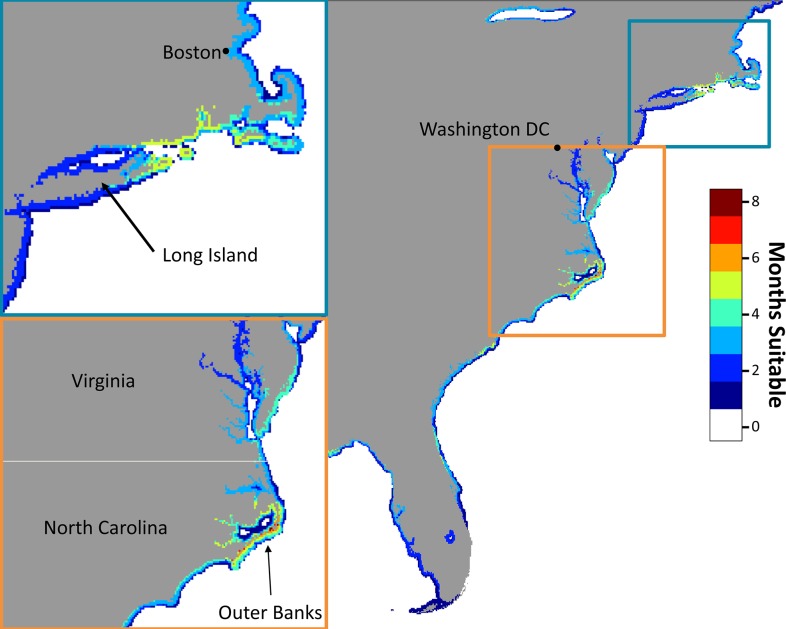
Habitat suitability hot spots for the Northwest Atlantic.Overlap of the monthly 25% core areas for JWS in the Northwest Atlantic. Colors represent the number of months that area represents core suitable habitat for JWSs. There are hot spots off Long Island Sound and off the Outer Banks of North Carolina (insets).